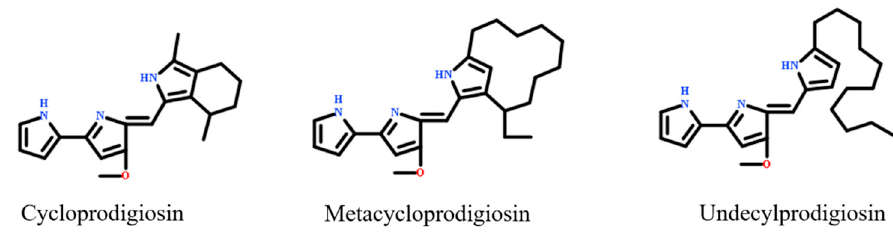
Figure 1. Structures of the cycloprodigiosin, undecylprodigiosin, and metacycloprodigiosin.